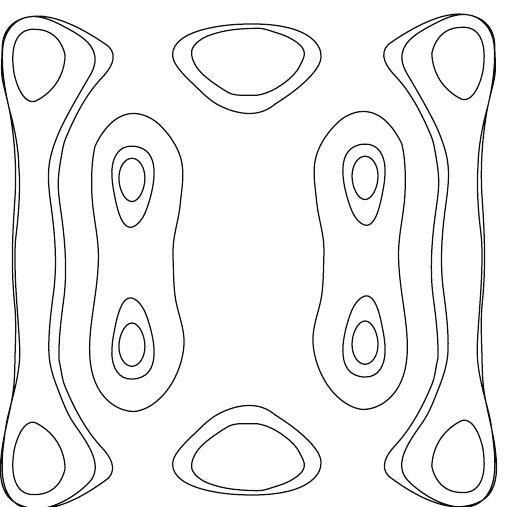
Figure5:Configurationof22limitcyclesofsystem((10a)and(10b)) with parameter conditions UP and PG is given.